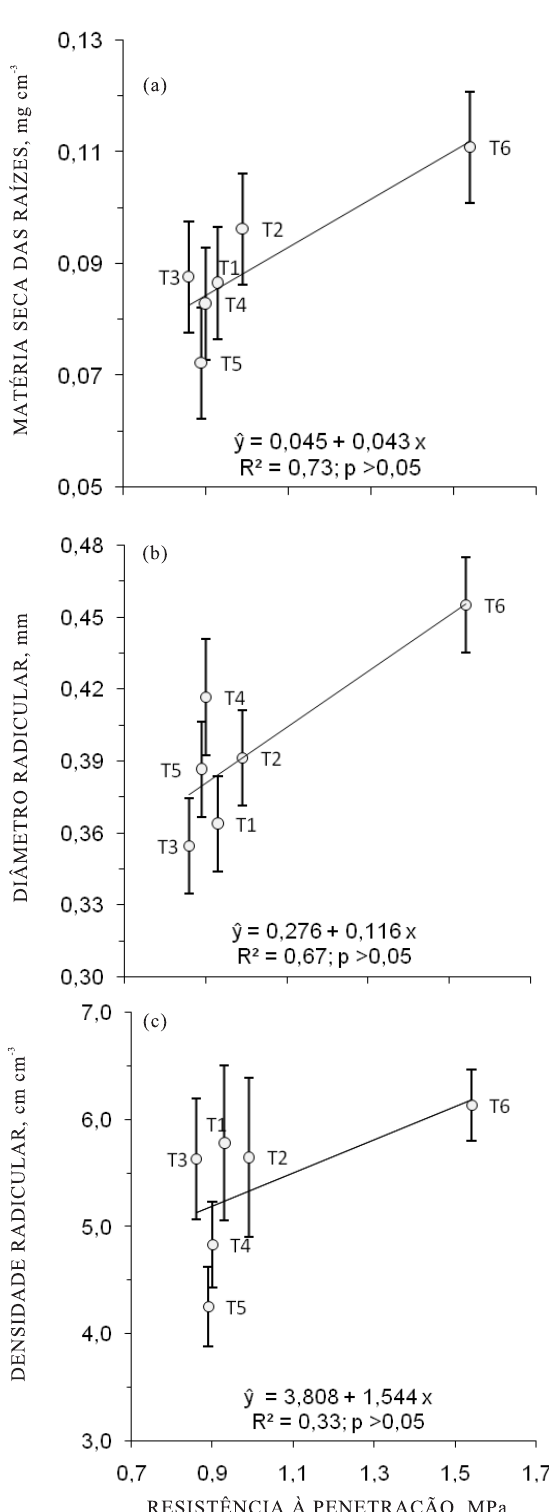
Figura 8. Regressão entre a resistência à penetração do Latossolo Vermelho na profundidade de 20– 30 cm e a massa de matéria seca das raízes, diâ- metro radicular e densidade do comprimento radicular. As barras referem-se aos erros-padrão das